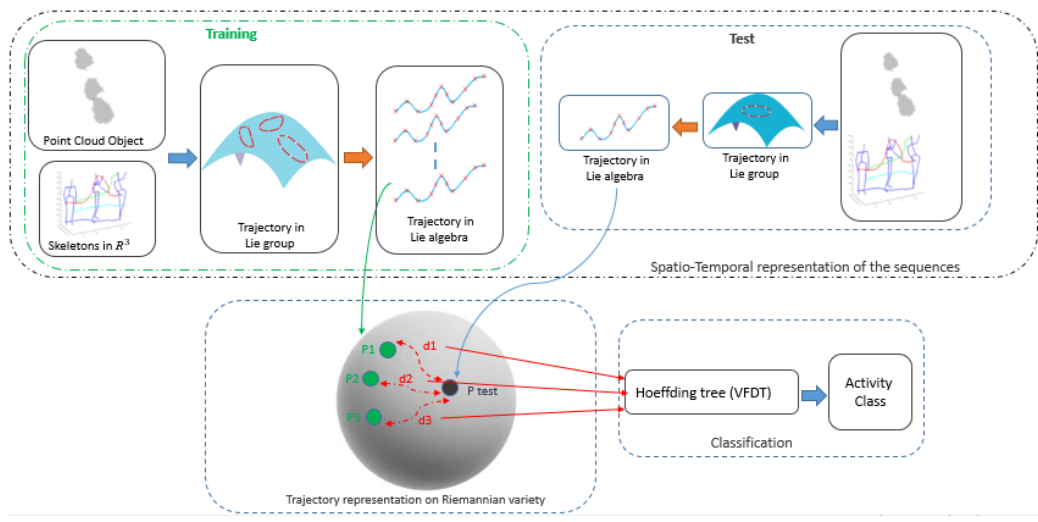
Figure 1. Overview of the proposed approach. VFDT, very fast decision